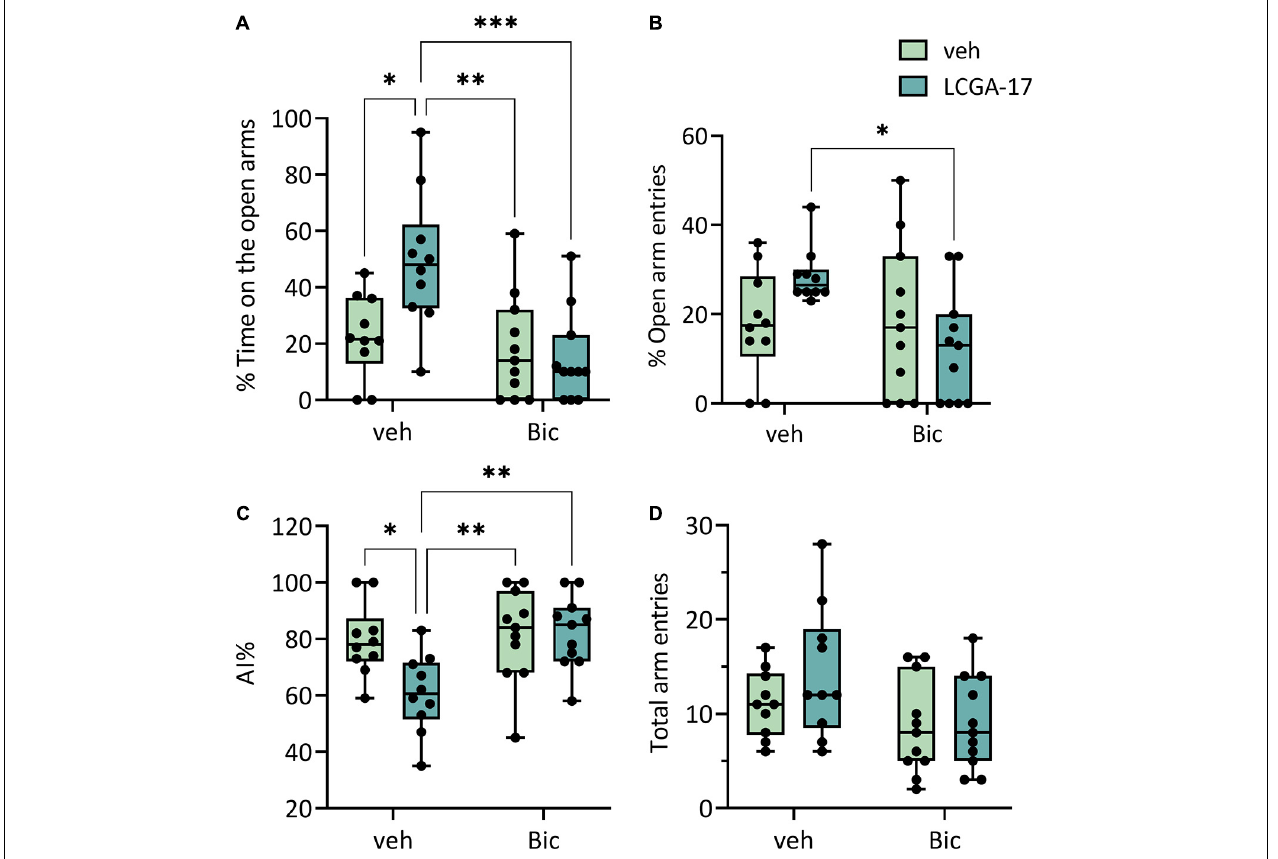
FIGURE 5 | The anxiolytic effects of LCGA-17 involve enhanced GABAergic transmission. The mice ( n = 10–11) were treated with LCGA-17 (20 mg/kg) or bicuculline (BIC, 5 mg/kg) or both, followed by analyses in the EPM. (A) The % time on open arms showed significant LCGA-17 [ F (1, 38) = 4.004, p = 0.05] and bicuculline effects [ F (1, 38) = 11.44, p = 0.002] and an LCGA-17 × bicuculline interaction [ F (1, 38) = 0.01, p = 0.01]. LCGA-17 increased the % time on open arms vs. vehicle- ( p < 0.05) and bicuculline-treated mice ( p < 0.01). Bicuculline co-administered completely blocked the effect of LCGA-17 [Bic + LCGA-17 vs. LCGA-17, p < 0.001; LCGA-17 + Bic vs. veh, p (ns)]. By contrast, bicuculline alone had no effect. (B) The number of open arm entries showed an LCGA-17 × bicuculline interaction [ F (1, 38) = 4.58, p = 0.039] and bicuculline reduced the LCGA-17 effect (LCGA-17 + Bic vs. LCGA-17, p < 0.05), again without effects of bicuculline alone. (C) The AI showed LCGA [ F (1, 38) = 4.38, p = 0.045] and bicuculline main effects [ F (1, 38) = 7.34, p = 0.01] and an LCGA-17 × bicuculline interaction [ F (1, 38) = 5.12, p = 0.029]. LCGA-17 reduced the AI compared to vehicle- (LCGA-17 vs. veh, p < 0.05) and bicuculline-treated mice (LCGA-17 vs. Bic, p < 0.01). This anxiolytic effect of LCGA-17 was reversed by cotreatment with bicuculline [LCGA-17 vs. LCGA-17 + Bic, p < 0.01; veh vs. LCGA-17 + Bic, p (ns)]. (D) Bicuculline slightly reduced the total arm entries in this test [ F (1, 38), p = 0.022] but post hoc pairwise group comparisons were not significant. ∗ p < 0.05, ∗∗ p < 0.01, ∗∗∗ p < 0.001; ANOVA, Tukey’s